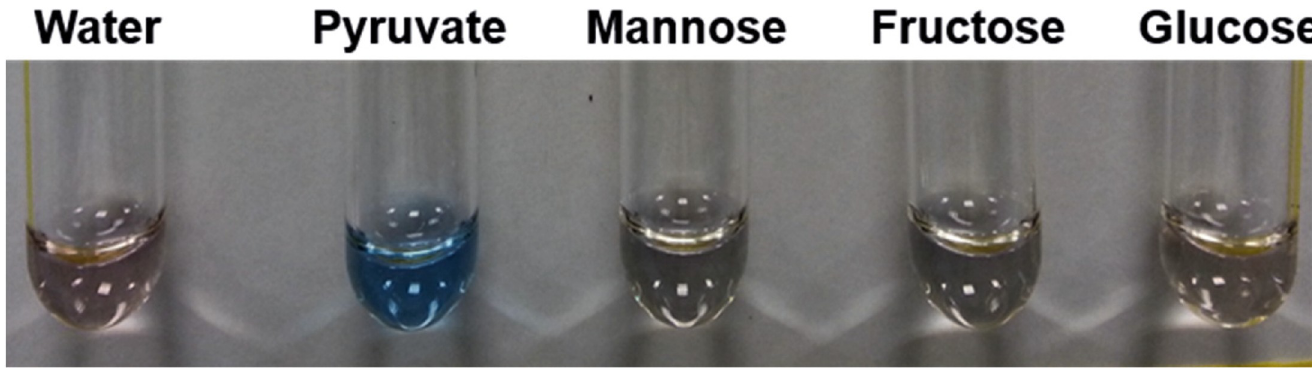
Fig 7. MW01 reacts with pyruvate to form a distinctive blue colored product. MW01 (0.1 mg/mL) in water and 0.5 wt/vol % aqueous solutions pyruvate and carbohydrates (mannose, fructose, and glucose).